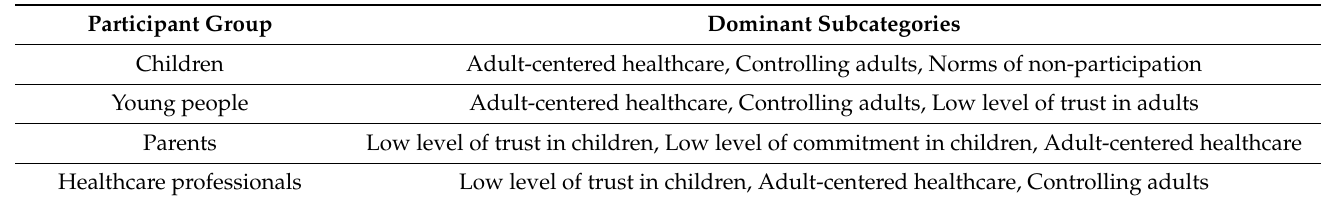
Table 3. Dominant subcategories, by participant